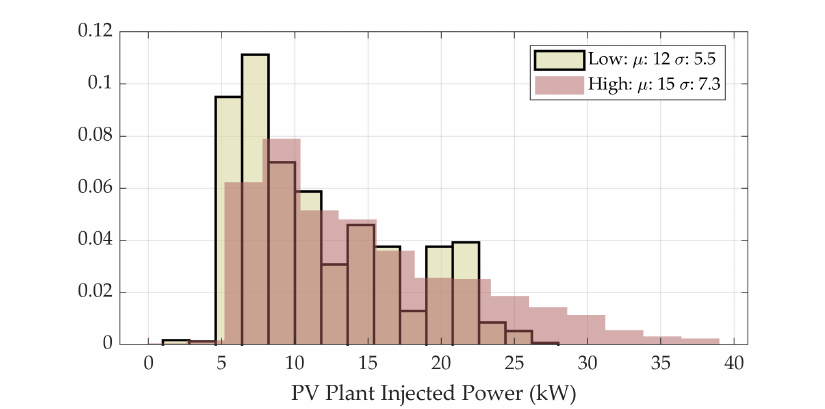
Figure 9. Maximum PV injection at optimal phase selection.